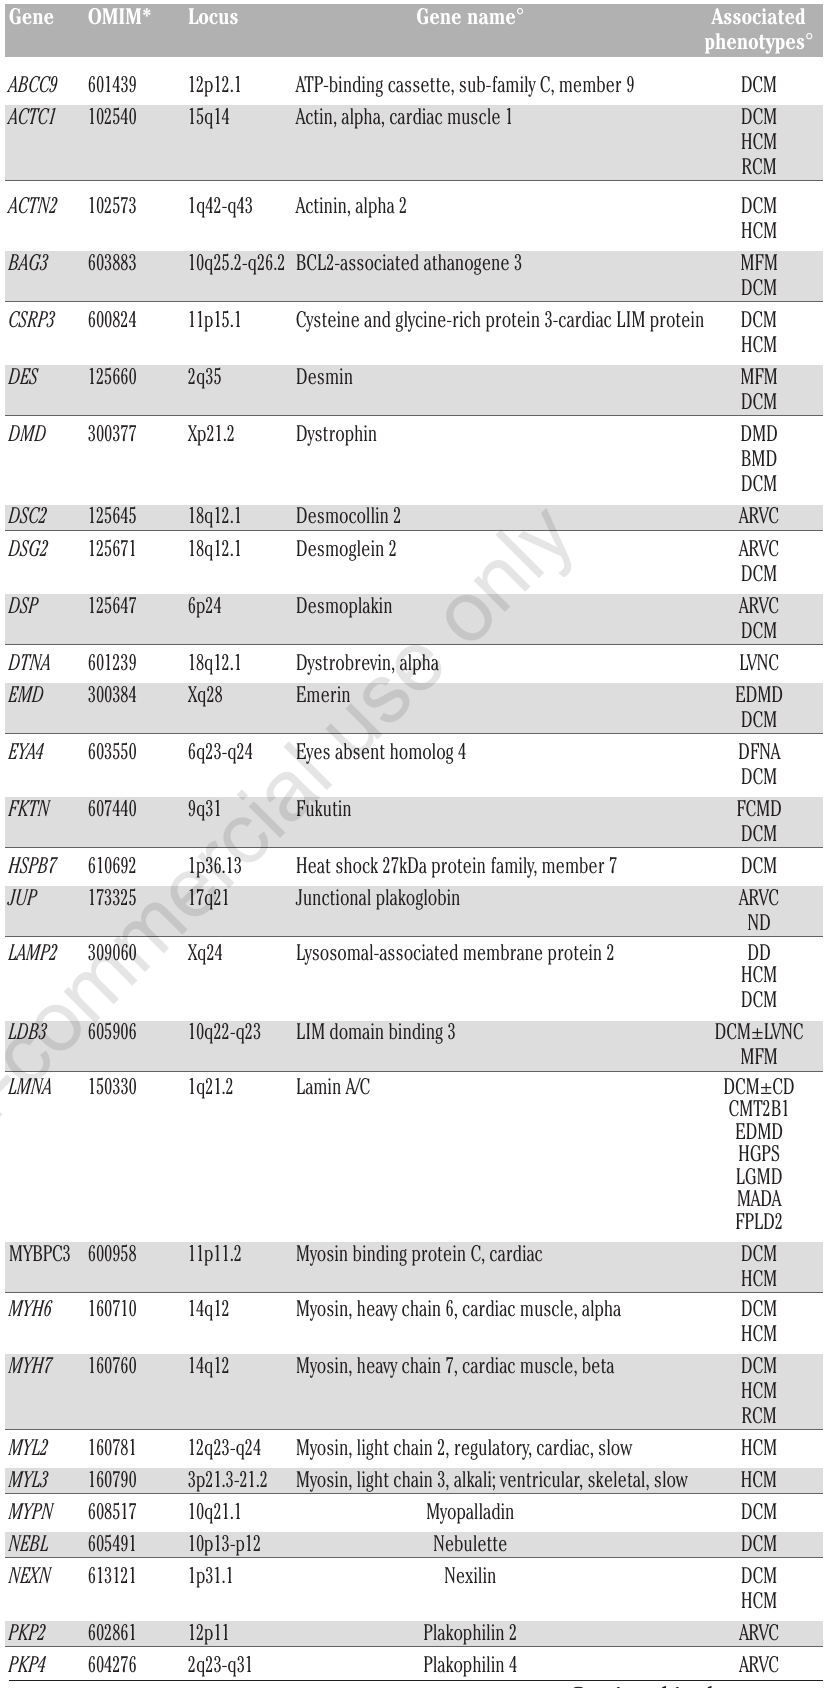
Table 1. Genes associated with cardiomyopathies and their allelic